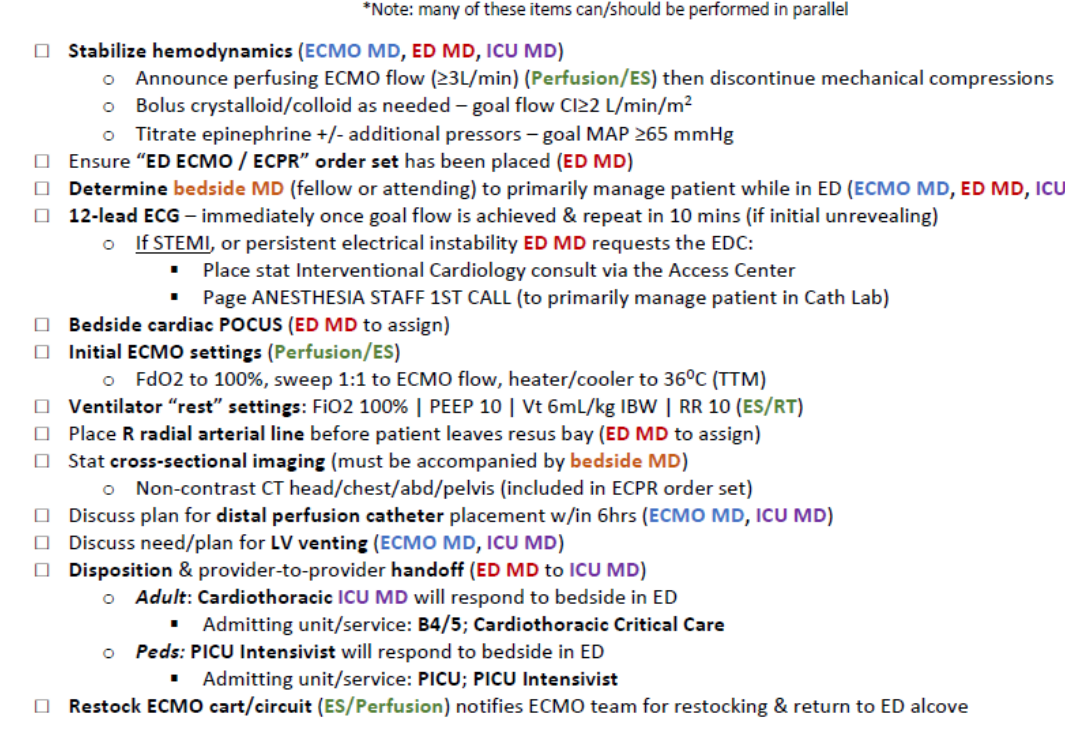
Figure 1. An example of a post-ECPR-cannulation checklist. ECMO MD = cannulating physician; ED MD = emergency medicine physician; perfusion/ES = perfusionist or ECMO specialist; ICU MD/Fellow = critical care physician. CI = cardiac index. MAP = mean arterial pressure. STEMI = ST segment elevation myocardial infarction. Access Center = centralized paging and operator resource for the hospital system. POCUS = point-of-care ultrasound. FdO2 = fraction of delivered oxygen. LV = left ventricular. B4/5 = institutional cardiothoracic ICU (or wherever adult VA ECMO patients are managed). PICU = pediatric intensive care unit.